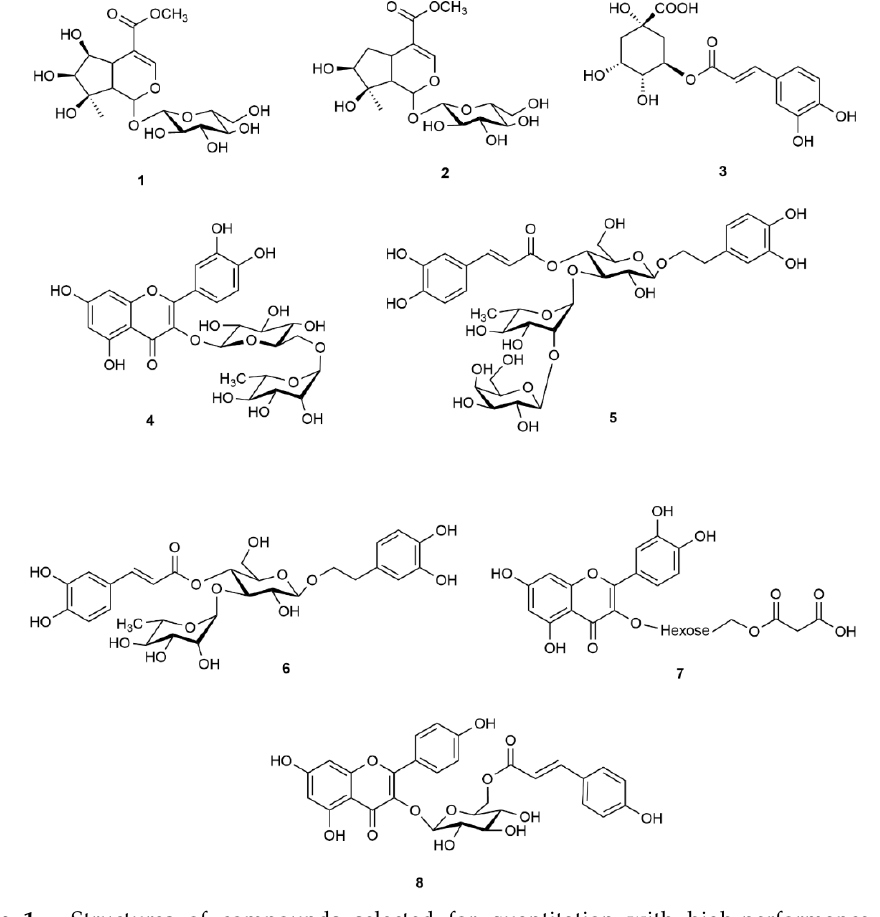
Figure 1. Structures of compounds selected for quantitation with high-performance liquid chromatography coupled with diode-array detection (HPLC–DAD) method.